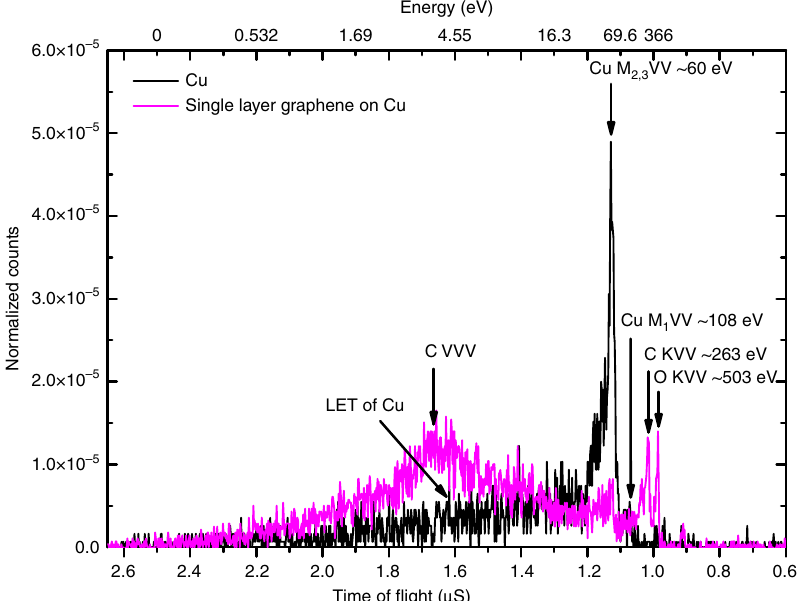
Figure 1 | Time of flight positron annihilation-induced Auger electron spectrum. TOF spectrum of electrons emitted from a single layer of graphene (magenta) on a polycrystalline Cu substrate following the creation of holes via positron annihilation. Also shown is the spectrum of electrons emitted from the polycrystalline Cu substrate (black) after removal of the graphene layer. The top axis shows the energy of the electrons calculated from their TOFs. Analysis in this paper shows that the strong peak at B 4eV ( B 1.65 m s) in the spectrum from graphene corresponds to emission of electrons as a result of an Auger transition in which the energy is provided by the filling of a deep hole in the 20eV wide valence band of the graphene layer created by matter–antimatter annihilation (Fig. 2). This peak is notably absent in the spectrum taken from the clean Cu substrate, consistent with the fact that the Auger electrons resulting from the filling of holes in the relatively shallow valence band of Cu do not have enough energy to leave the surface. The TOF-PAES spectrum of the graphene also shows peaks corresponding to the Auger relaxation of core holes in C (KVV), adsorbed O (KVV) and in Cu (MVV) and the spectrum from clean Cu substrate show peaks corresponding to the M 2,3 VVand M 1 VVAuger peaks. The use of an incident 1.25eVpositron beam to create the holes eliminates the normally overwhelming beam induced secondary electron background that prevents other photon or electron based techniques from making a direct measurement of the valence Auger